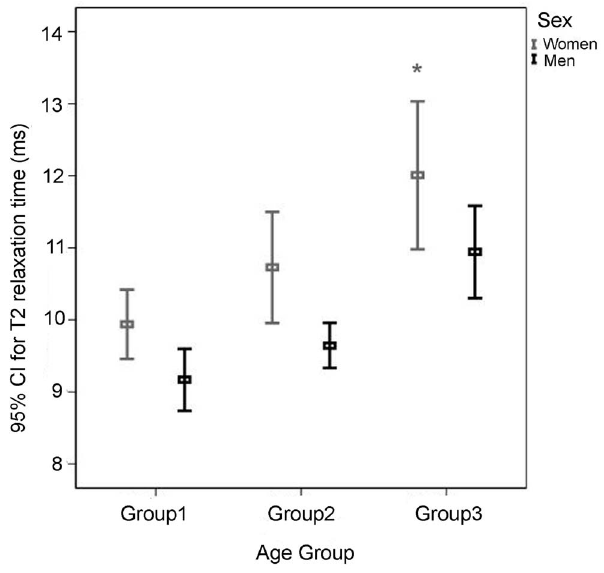
Figure 3. T2 values of both menisci for three age groups of women and men. In women, T2 values increase significantly from group 1 to group 3 (* P , 0.001 as compared with group 1). Women show significantly greater T2 values than men in all three age groups (with P =0.001, 0.004, and 0.049, respectively).